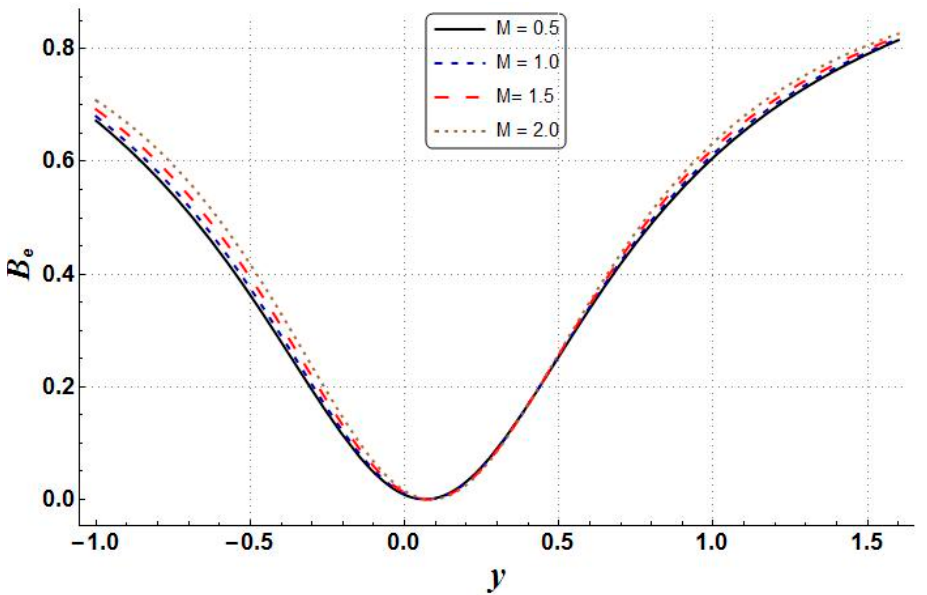
Figure 31. Influence on B e through changing values of M , where γ = π φ = 0.05, k = 2, a = 0.6, m = 1, d = 0.7, Br = 0.2, b = 0.5, ∈ = 2, η = 0.8.